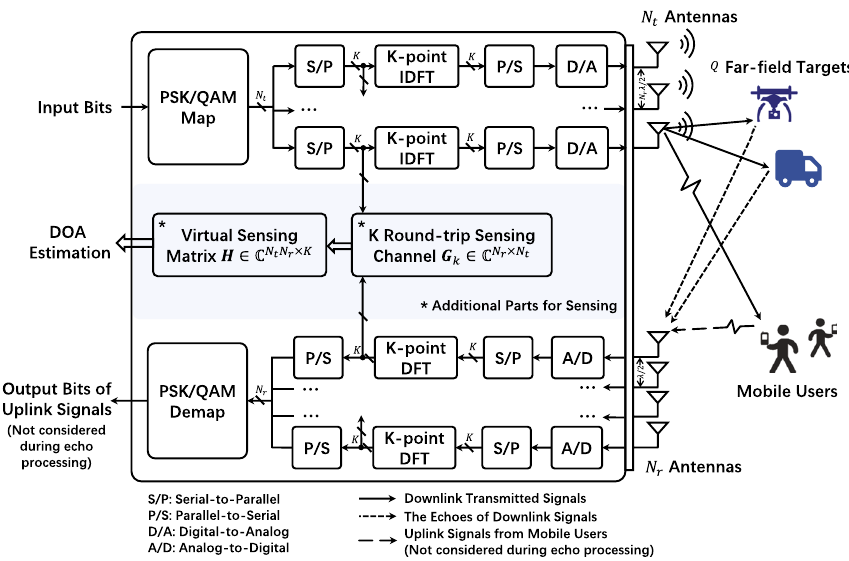
Fig. 1 Illustration of the deployed joint MIMO sensing and communication